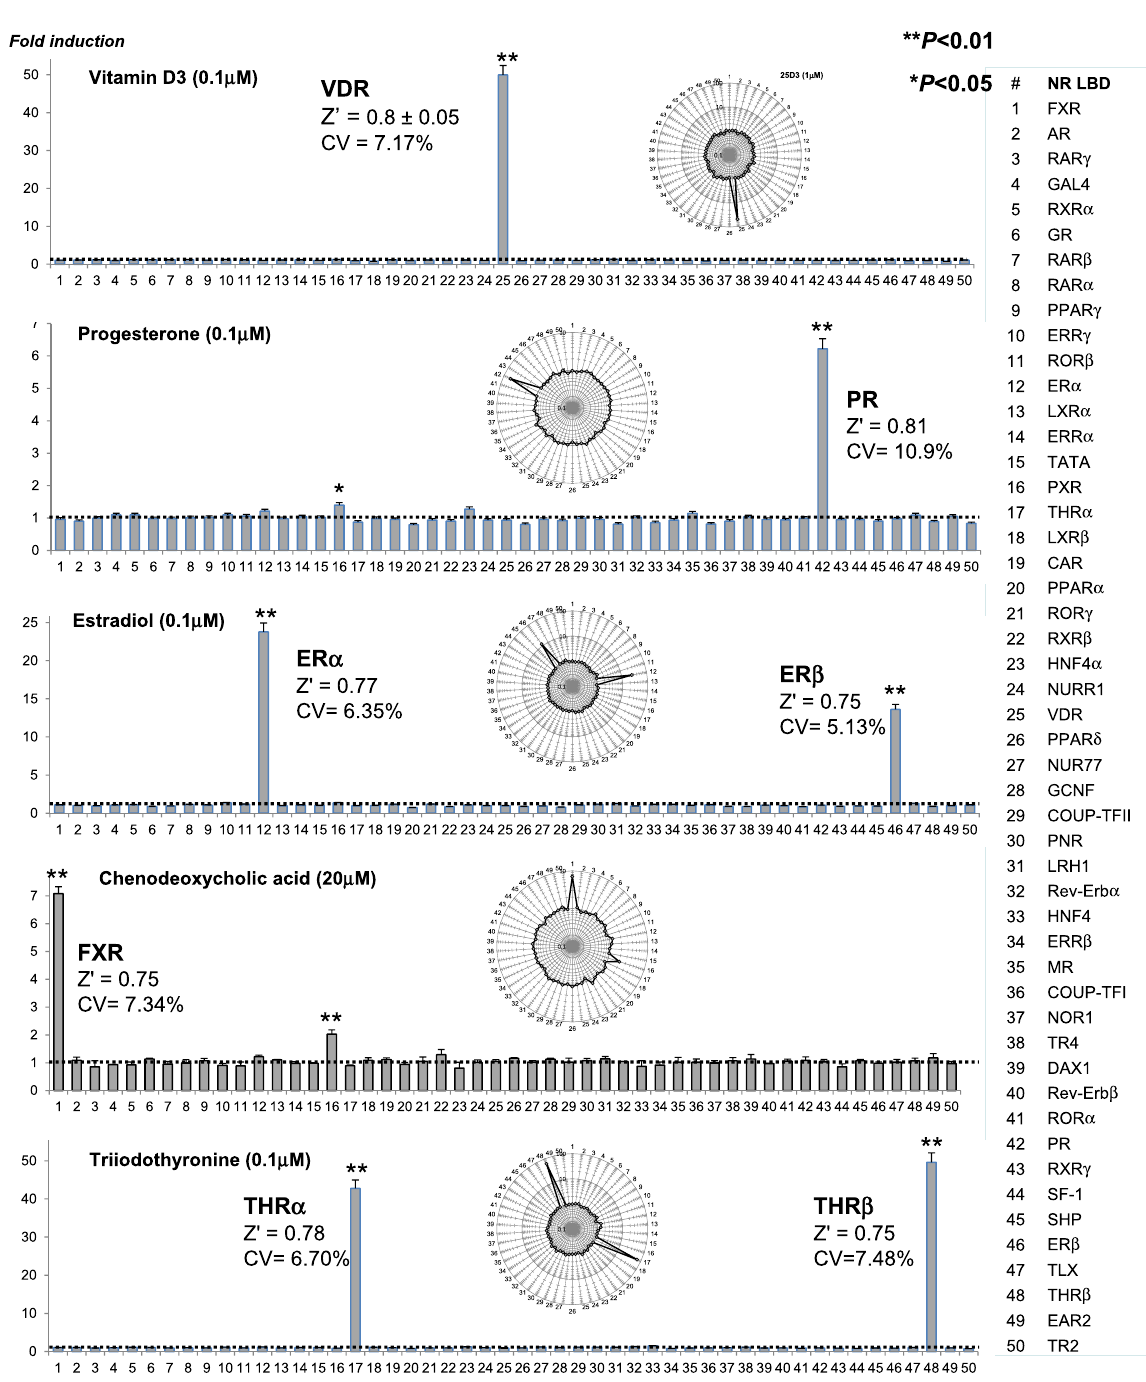
Figure 2. Profiling NR ligand activity by the FACTORIAL NR. The NR activity profiles for physiological (A) and synthetic (B ) ligands. The NR activity profiles show the GAL4-NR activity in stimulated cells normalized by that in vehicle-treated cells. Bar graphs show NR activity fold-changes on a linear scale and radial graphs show log-transformed values. Each profile is an average of three independent FACTORIAL NR assays. Significant NR responses are marked (**P < 0.01; *P < 0.05). The Z’- factor and CV values for individual responses are averages of three independent assays. ( C) The reproducibility of NR activity profiles for RXR agonist bexarotene in two independent experiments. Each profile is an average of three independent FACTORIAL NR assays. The profile similarity calculated as Pearson correlation coefficient r . The Z’-factor and CV values for individual responses are averages of three independent assays in one experiment. The aggregate < Z’ > and < CV > values are average across all significant